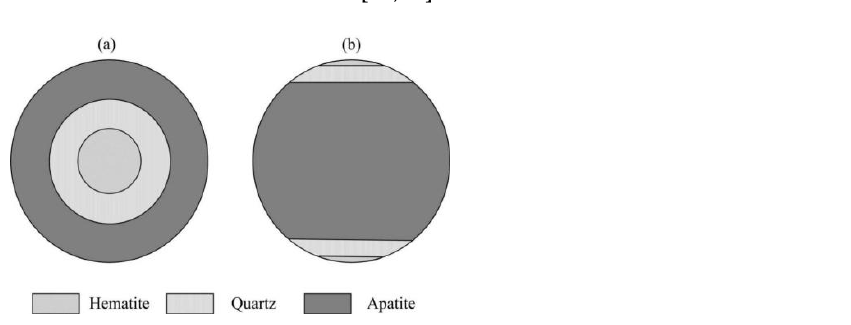
Figure 4. Schematic diagram of the mineral composition of oolitic ore: ( a ) top view; ( b ) front view.